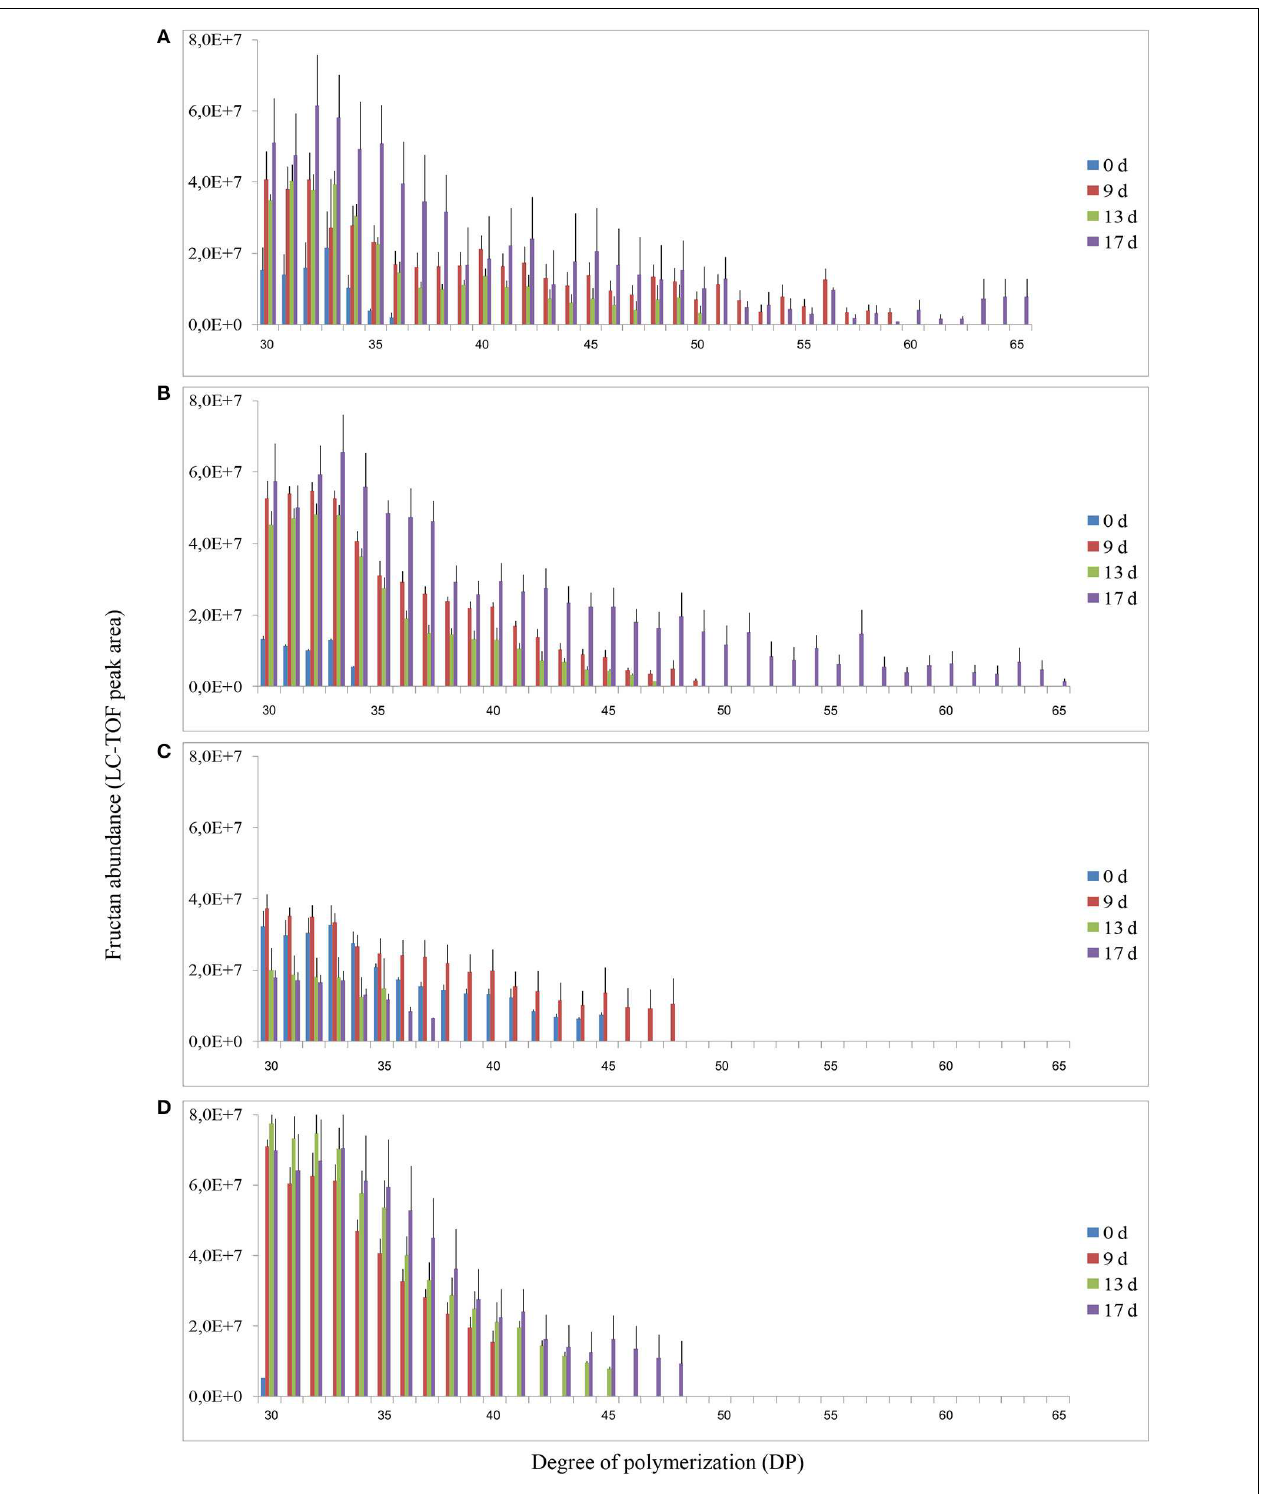
“Falster.” Fructan DP and composition on d 0, 9, 13, and 17 of cold acclimation are shown. Relative quantification of fructan oligosaccharides and polysaccharides was carried out using LC-ESI-TOF MS. Data represent mean ± SE obtained from three replicates of the